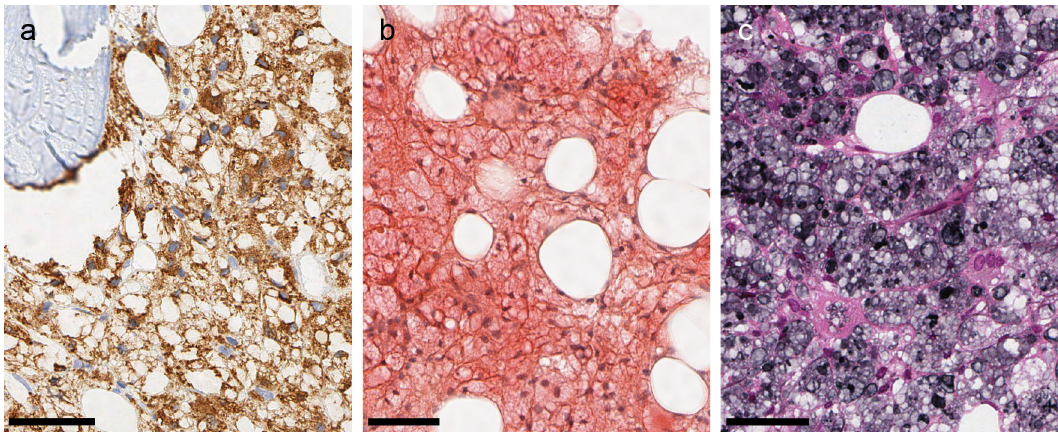
Figure 2. Staining properties. All micrographs are from the same bone marrow biopsy. (a) CD 68/PGM1: The vacuolated cells are CD68-positive histiocytes. (b): Congo red stain: Vacuole content stains faintly red. (b) PASM: Vacuole content stains grey or black. All scale bars 50 μ